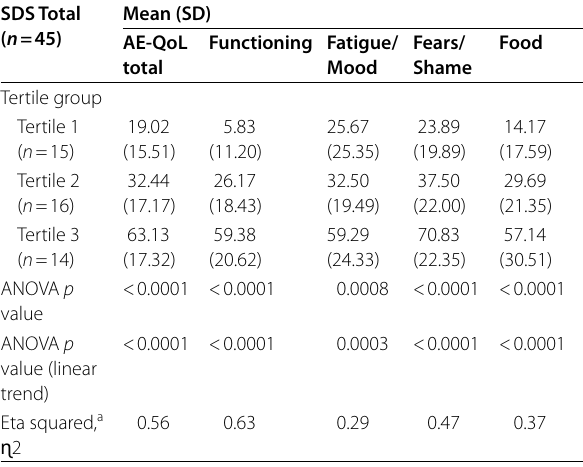
Table 6 Differences in AE-QoL scores at Week 5 between ranked SDS tertile groups of increasing severity for